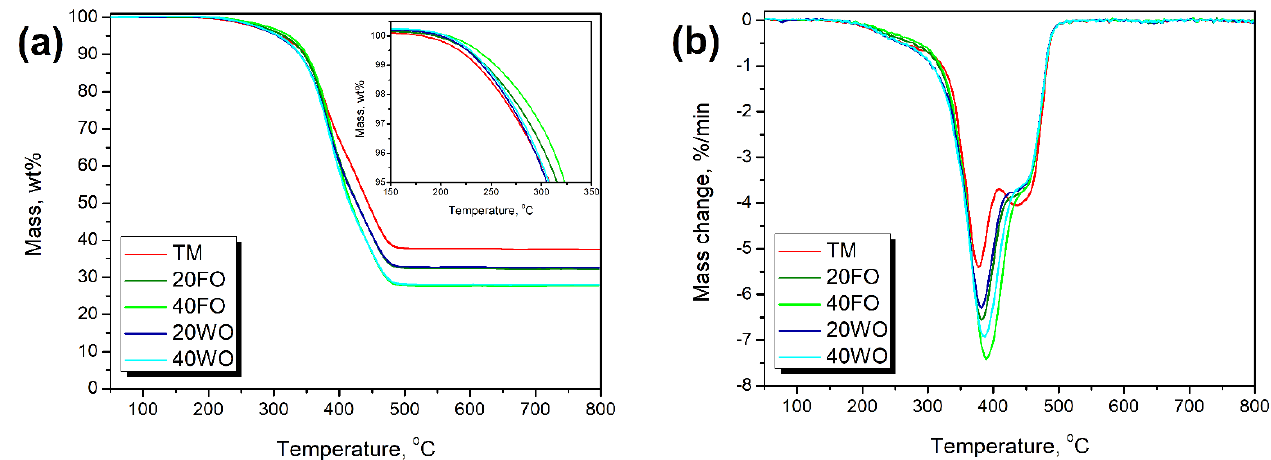
Figure 5. Temperature plots of ( a ) mass loss and ( b ) mass loss rate of applied GTR samples. Table 6. The results of thermogravimetric analysis of GTR